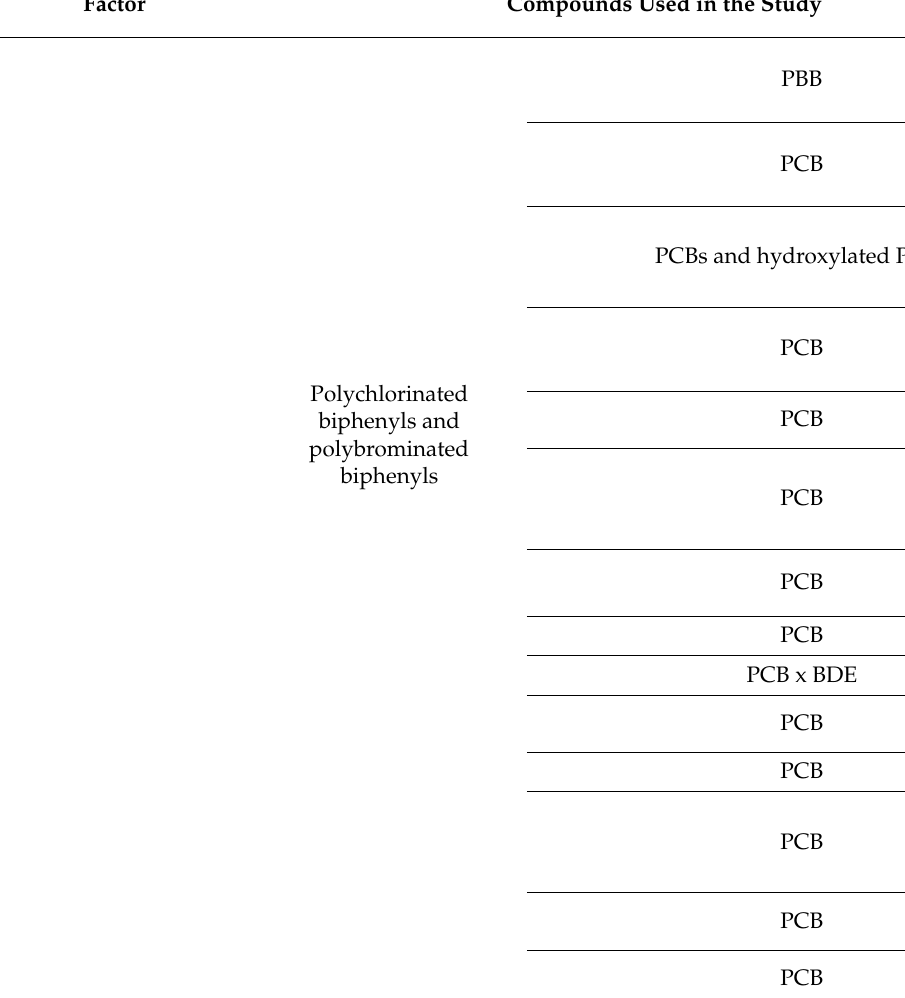
Effect on Hormone Number of Participants Levels